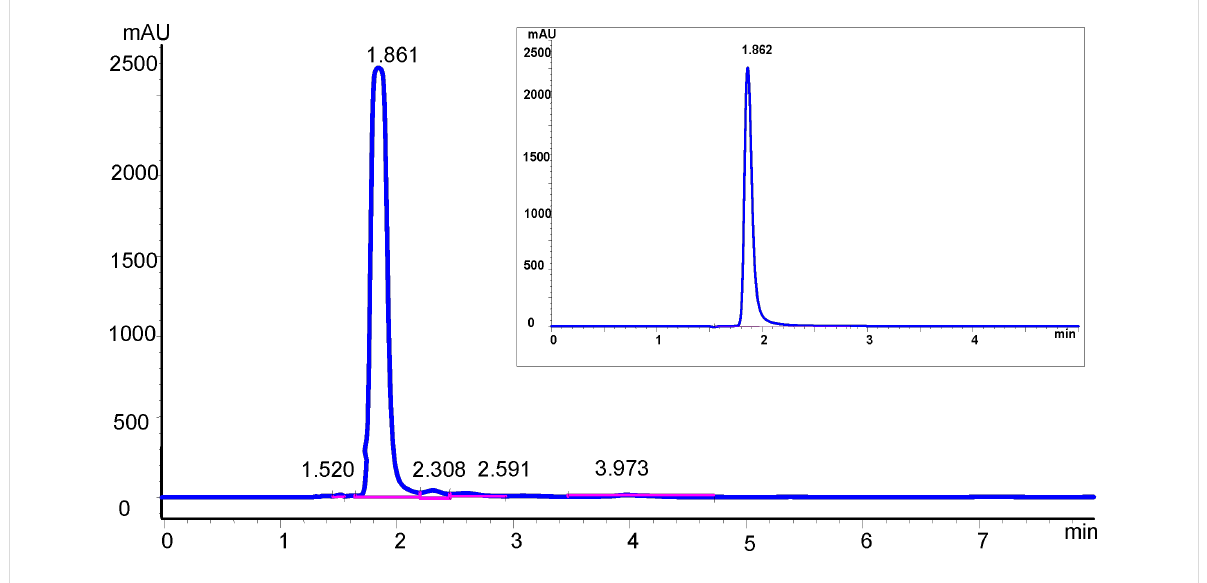
Figure 7: Typical HPLC chromatograms of sample of (1/5)-diluted juice 1 and 0.5 mmol/L AA standard (inset).